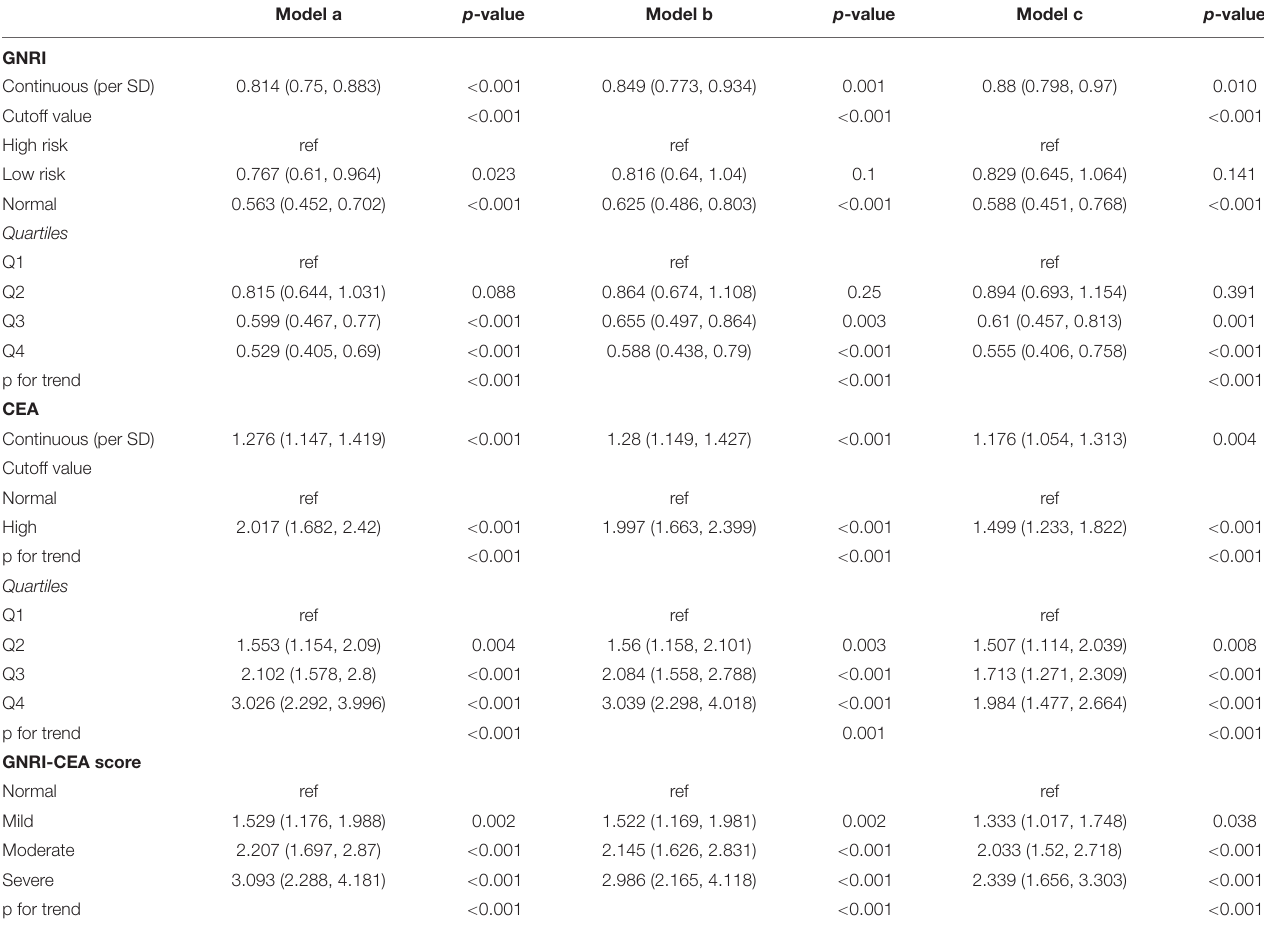
TABLE 2 | Trend test of the relationship between GNRI/CEA and progression-free survival. Model a p -value Model b p -value Model